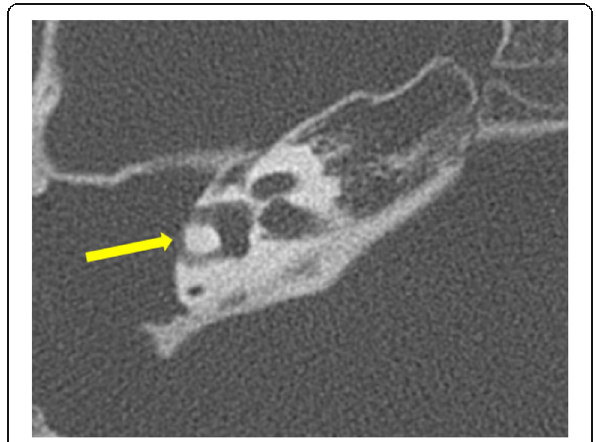
Fig. 11 Axial CT image showing erosion of the lateral wall of the lateral semicircular canal (arrow) with the formation of labyrinthine fistula